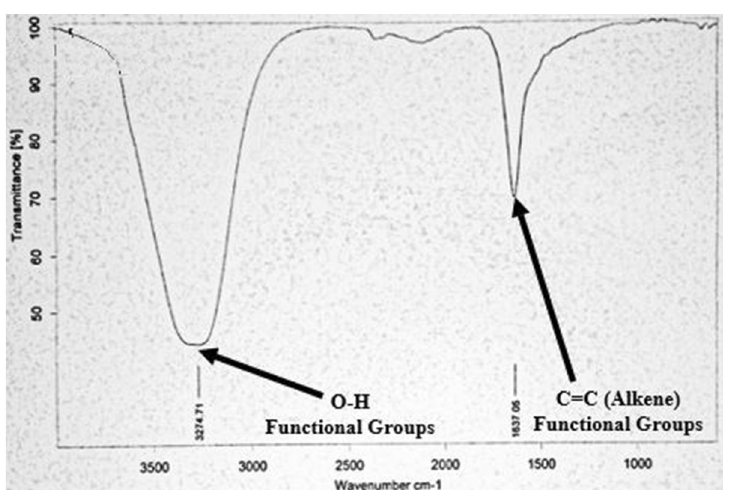
Figure 8. FTIR band spectrum study of SeNPs synthesized from Citrus limon (Lemon) fresh peels